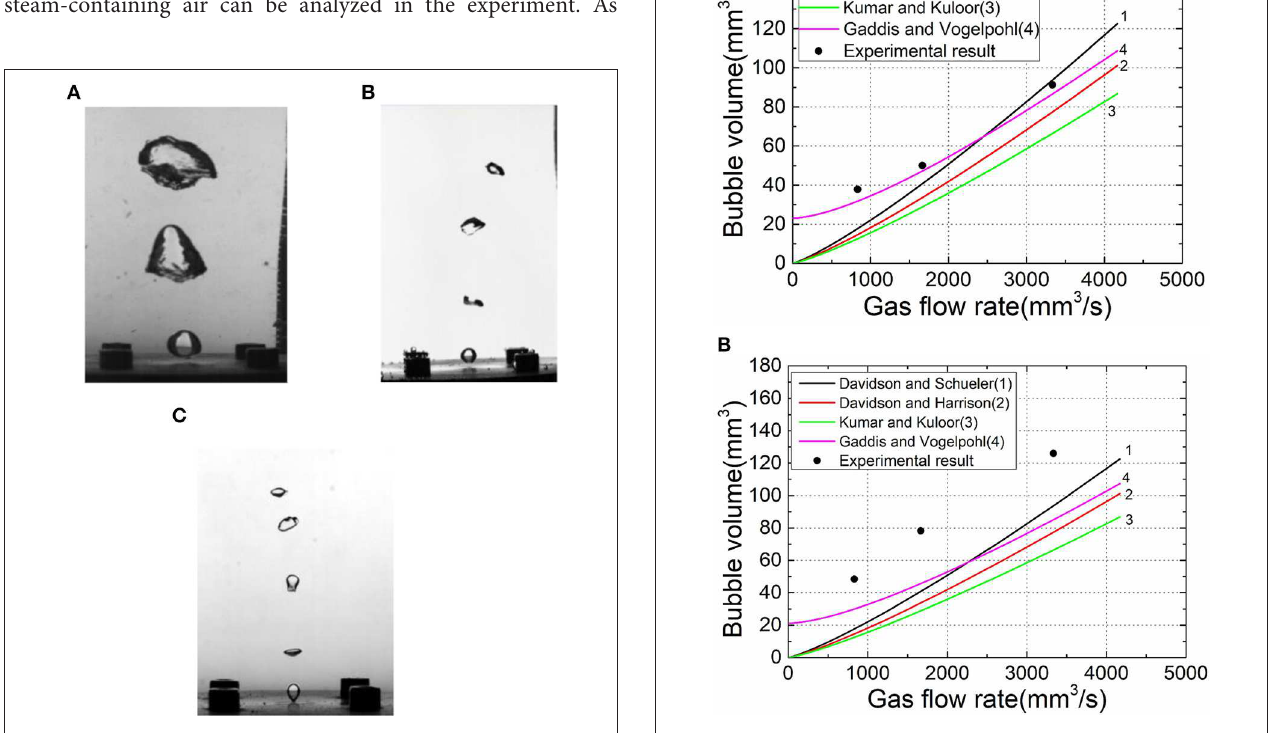
FIGURE 5 | Experimental acquisition of bubble volume values compared with existing calculation models. (A) 25 ◦ C liquid temperature. (B) 60 ◦ C liquid